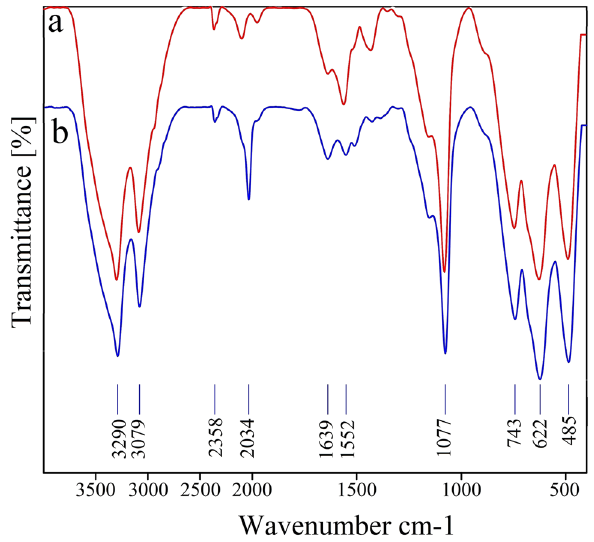
Figure 19. FT-IR spectra of (a) Sm-bis(PYT)@boehmite and (b) recovered